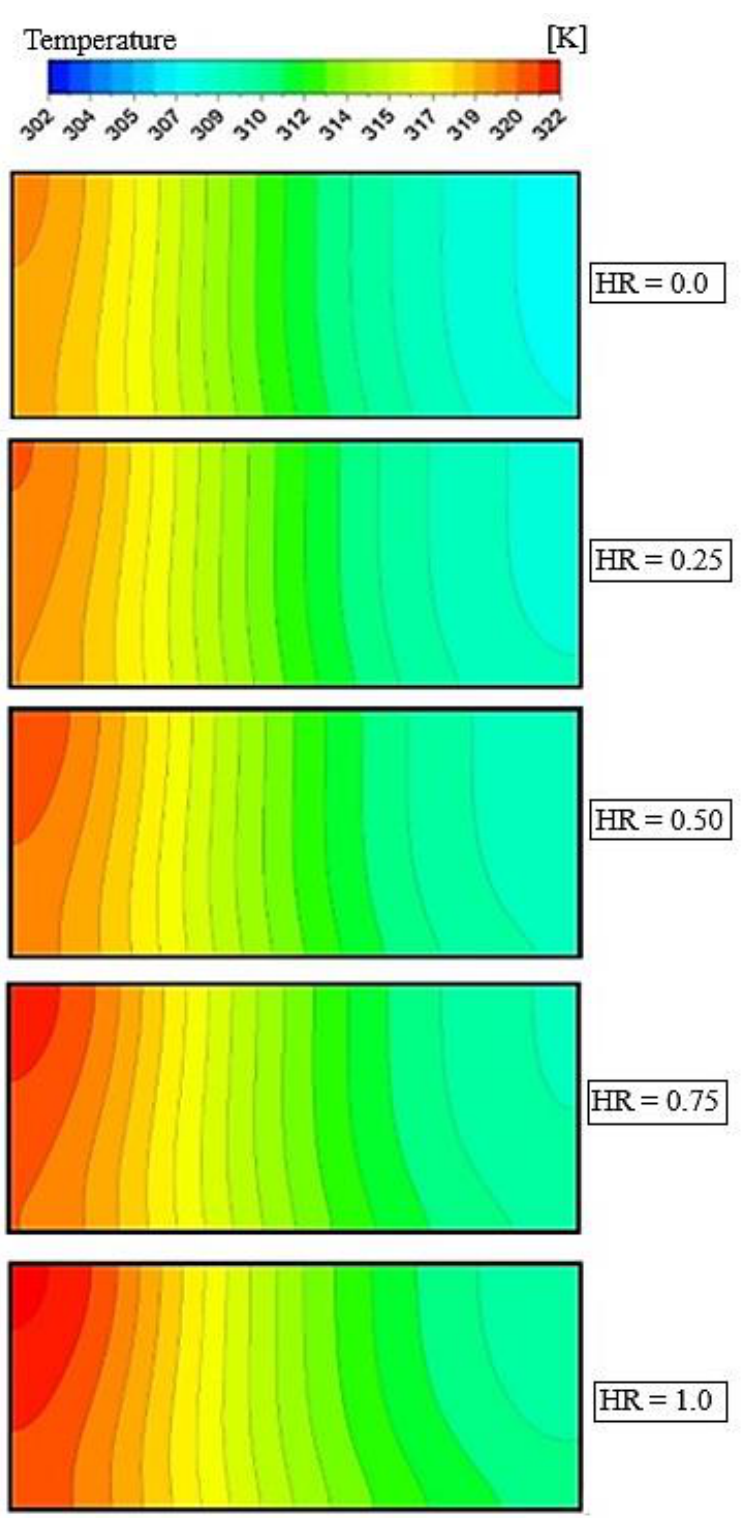
Figure 11. Temperature contours on the cavity bottom wall at different height ratios (0.0 HR 1.0).